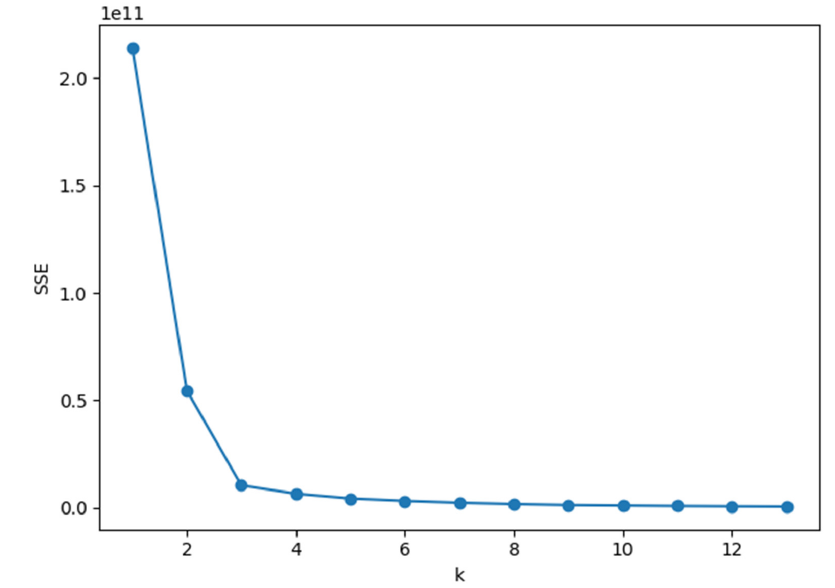
Figure 4. Relationship between k and sum of the squared errors ( SSE ) in Tulum2010.